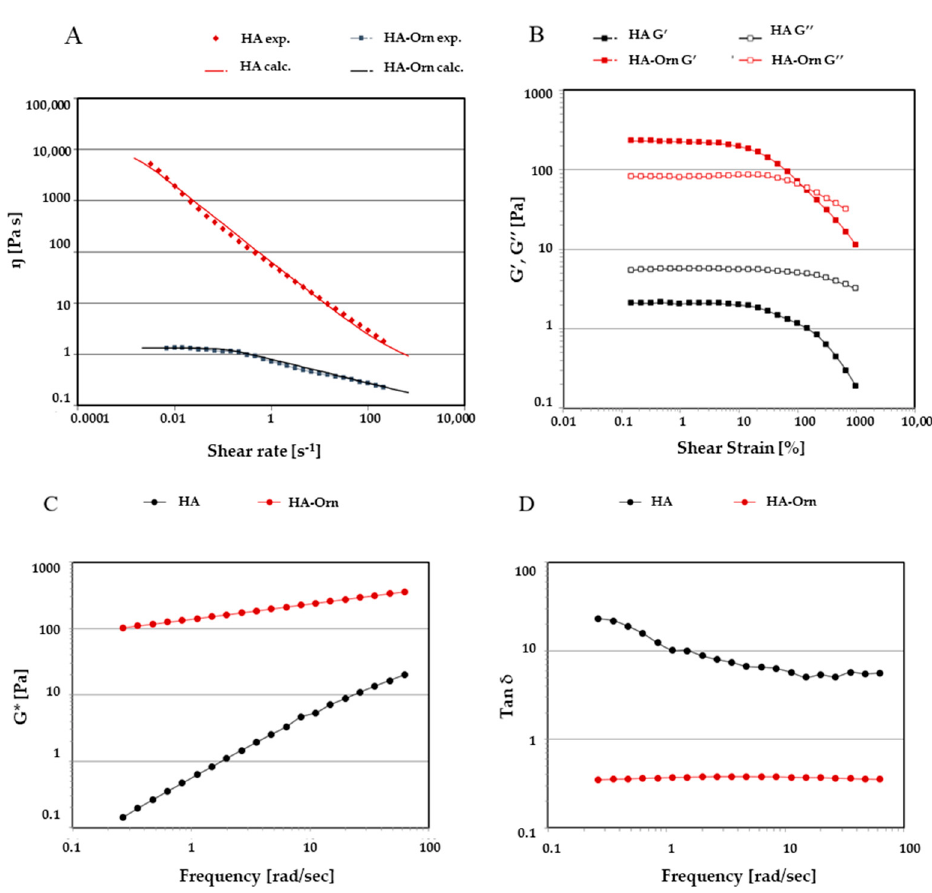
Figure 7. The trend of viscosity values (panel A ), G ′ and G ″ moduli (panel B ), complex moduli (G*) (panel C ), and damping factor (tan δ ) (panel D ).